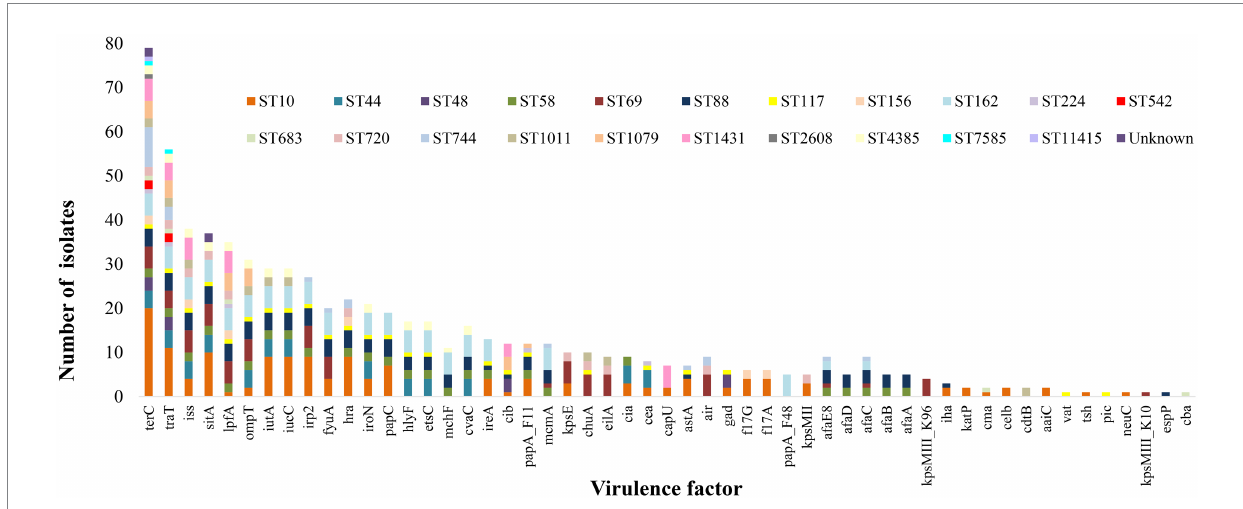
FIGURE 3 Distribution of virulence genes amongst the different ST of E. coli isolated from effluent and ICW-treated farm waste water. terC , Tellurium ion resistance protein; tra T, Outer membrane protein complement resistance; iss , Increased serum survival; hra , Heat-resistant agglutinin; sit A, Iron transport protein; lpf A, Long polar fimbriae; omp T, Outer membrane protease (protein protease 7); iut A, Ferric aerobactin receptor; iuc C, Aerobactin synthetase; irp 2, High molecular weight protein 2 non-ribosomal peptide synthetase; fyu A, Siderophore receptor; hra , Heat-resistant agglutinin; iro N, Enterobactin siderophore receptor protein; pap C, Outer membrane usher P fimbriae; hly F, Hemolysin F; ets C, Putative type I secretion outer membrane protein; mch F, ABC transporter protein MchF; cva C, Microcin C; ire A, Siderophore receptor; cib , Colicin ib.; pap A_F11, Major pilin